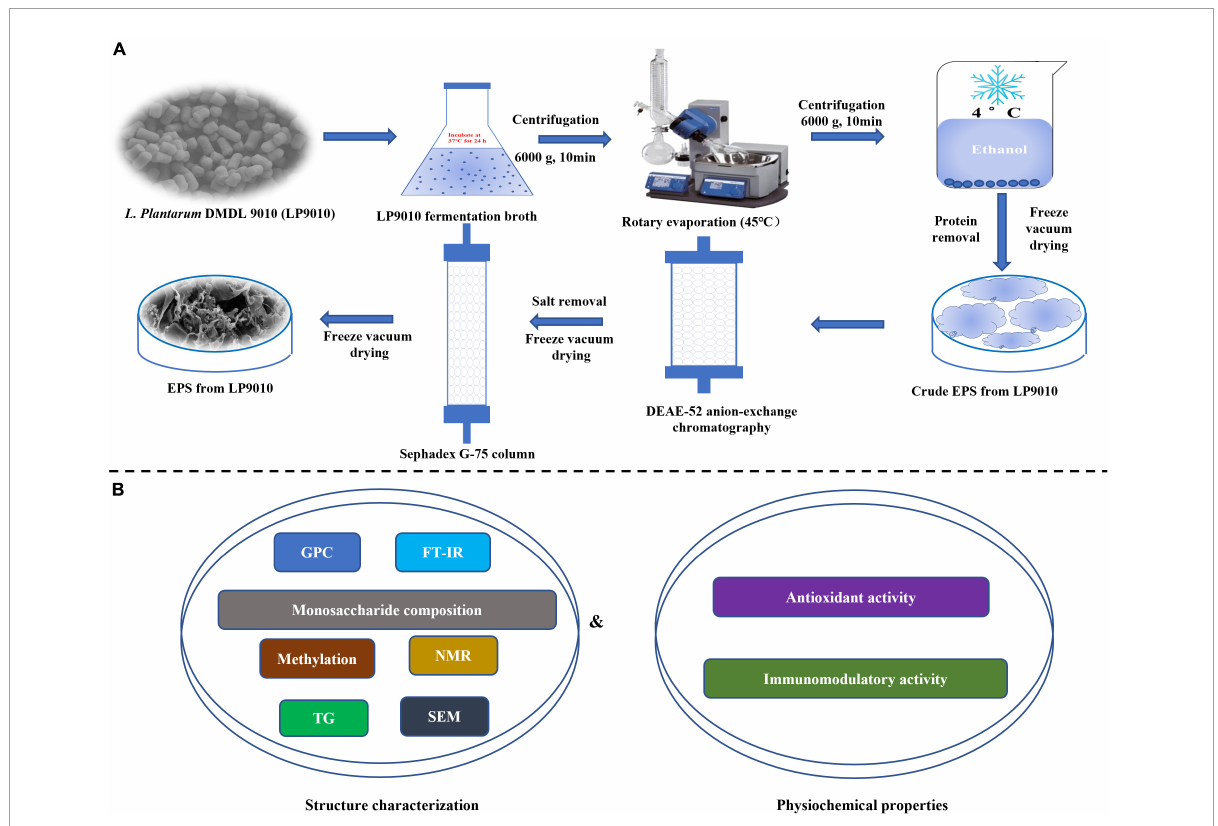
FIGURE1 The procedure of the whole experiment. (A) The investigations of isolation, purification, and molecular weight determination of exopolysaccharides (EPS). (B) The experiments of structure characterization and biological.